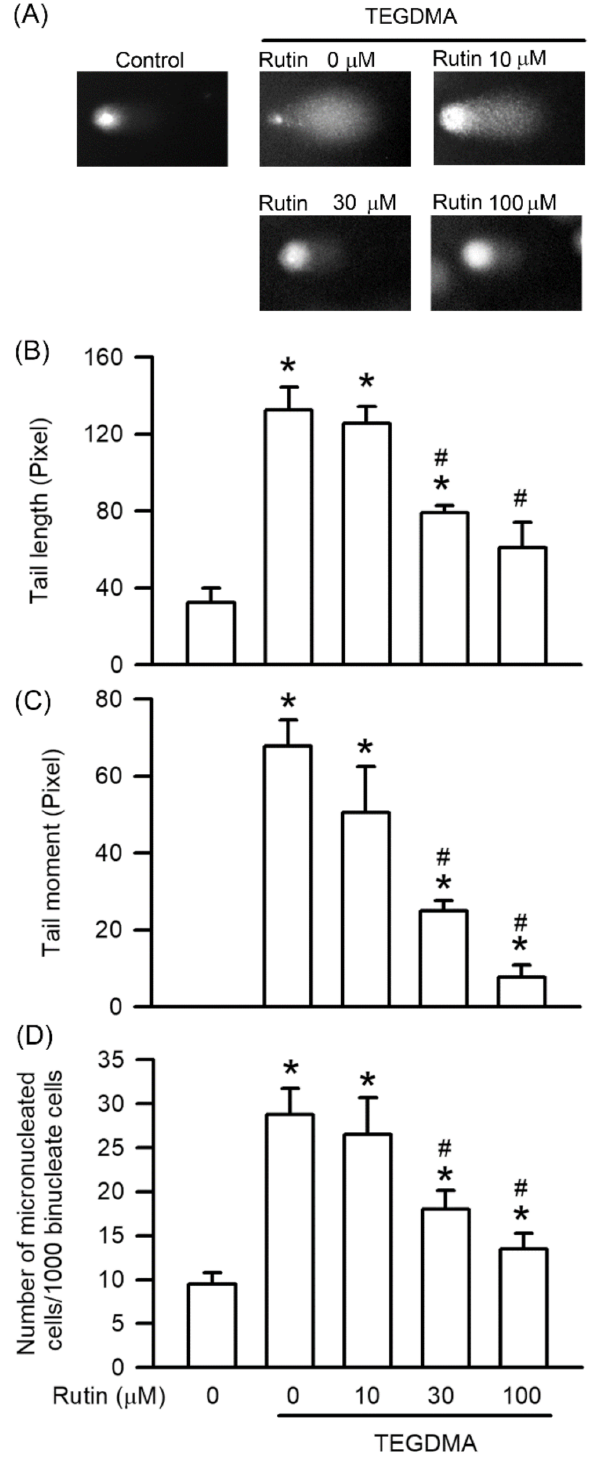
Figure 3. Effect of rutin on TEGDMA-induced genotoxicity via COMET and MN assay in RAW264.7 macrophages. ( A ) was gel electrophoresis of DNA damage from COMET assay. ( B , C ) were quantifi- cations of tail length and tail moment, respectively. ( D ) was the quantifications of MN formation. Values are expressed as mean ± S.D. of three times per group. * Represents significant difference between the indicated and control groups, p < 0.05. # Means significant difference between the indicated and TEGDMA groups, p <